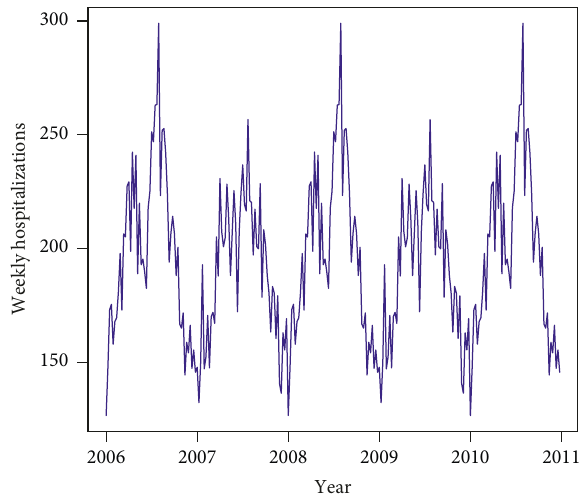
Figure 17: Weekly number of hospitalizations.